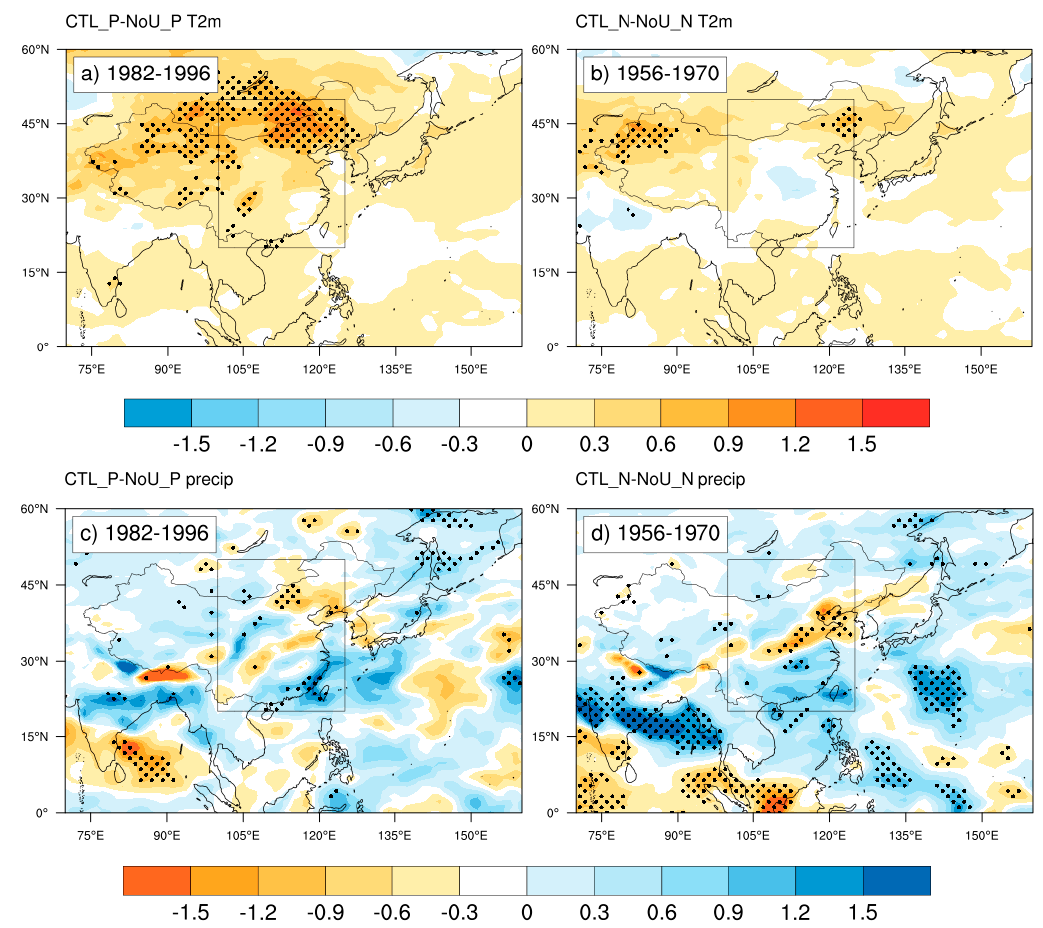
Figure 4. The difference fields (CTL_P minus NoU_P and CTL_N minus NoU_N) for 2-m air-temperature ( a , b ; units: ◦ C) and precipitation ( c , d ; units: mm/day). ( a , b ) use the SST of 1982–1996 (CTL_P minus NoU_P), and ( c , d ) use the SST of 1956–1970 (CTL_N minus NoU_N). The stippled area indicates above 90% confidence level, and relatively concentrated urban area is marked by the black rectangle.